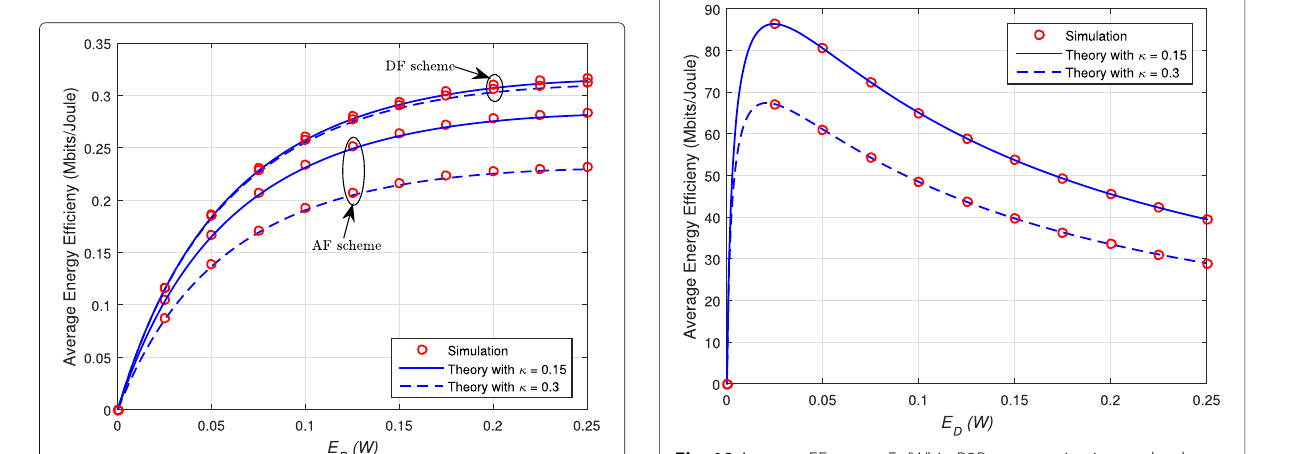
Fig. 10 Average EE versus E D (W) in P2P communication under the impact of